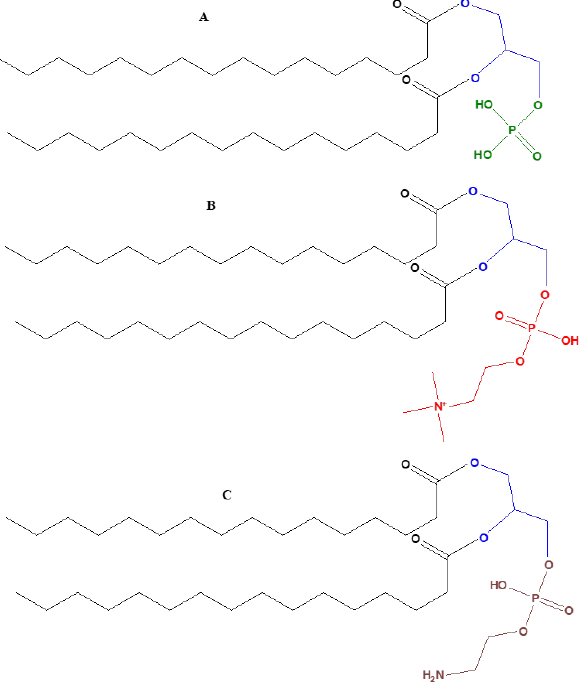
Figure 12. The generic structures of the key phospholipids: (A) phosphatidic acid with headgroup containing phosphate group (green color), (B) phosphatidylcholine with headgroup constituting of phosphocholine (red color), and (C) phosphatidylethanolamine with headgroup containing phos- phoethanolamine (reddish-brown). Prebiotic syntheses of phospholipids such as phosphatidic acid, phosphatidyl glyc- erol, and phosphatidyl glycerol phosphate (0.015%–0.2%) have been reported by employ- ing chimyl alcohol, dodecanoate, glycerol, and phosphate. The condensation reactions oc- curred at 65 °C (12 h) (Figure 12). The reported reaction was promoted by dicyanamide